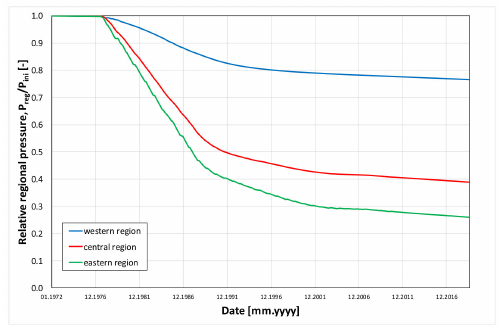
Figure 20. Evolution of relative average regional pressures.